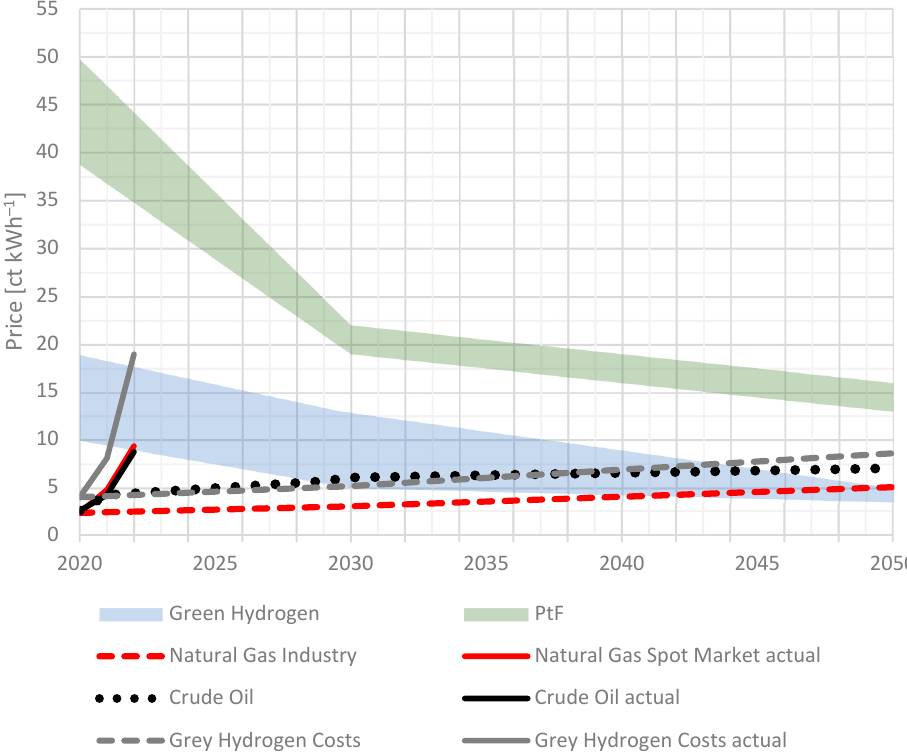
Figure 1. Expected production costs of green hydrogen and synthetic fuels up to 2050 compared to price projections for grey hydrogen, natural gas (prices for industry customers), and crude oil (dashed lines), without consideration of increasing CO 2 emission costs. Prices for grey hydrogen, natural gas, and crude oil in solid lines represent the actual price developments. Linearly interpolated data based on